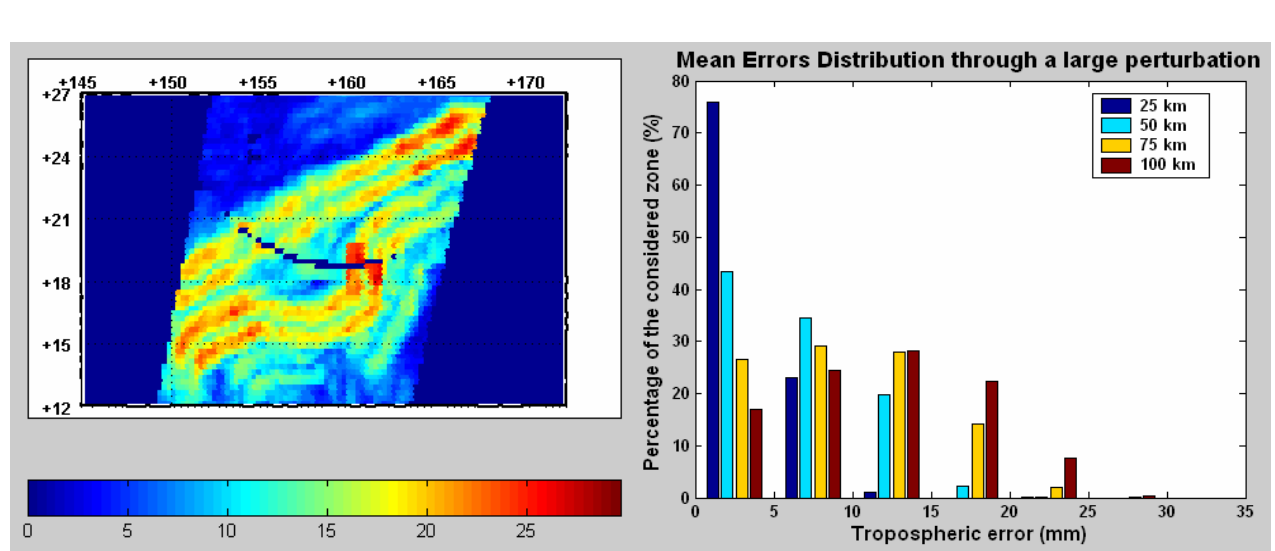
Figure 14. (a) Spatial differences in wet tropospheric delays over a large atmospheric feature (typically a few hundred kilometers wide) in mm (b) Statistical distributions of the tropospheric errors over the